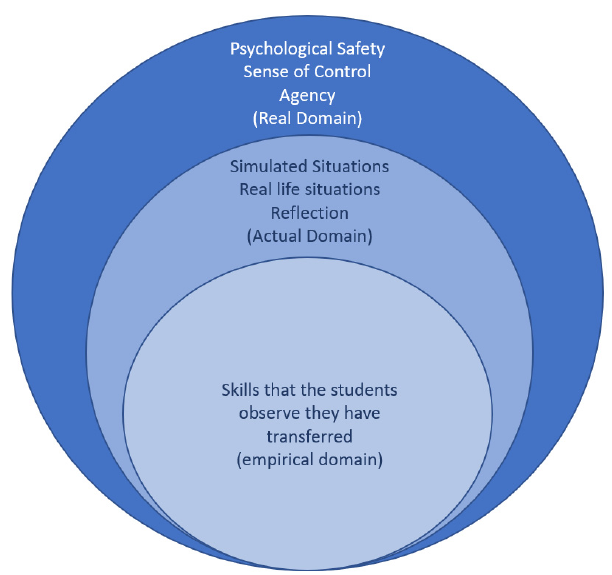
Figure 2. Critical realist depiction of the proposed model. Table 5. Examples of Critical/Memorable Incidents (Excerpts) involving mechanisms for transfera- bility (Mechanisms—real domain) of leadership skills (Skills—empirical domain). Skills—Empirical